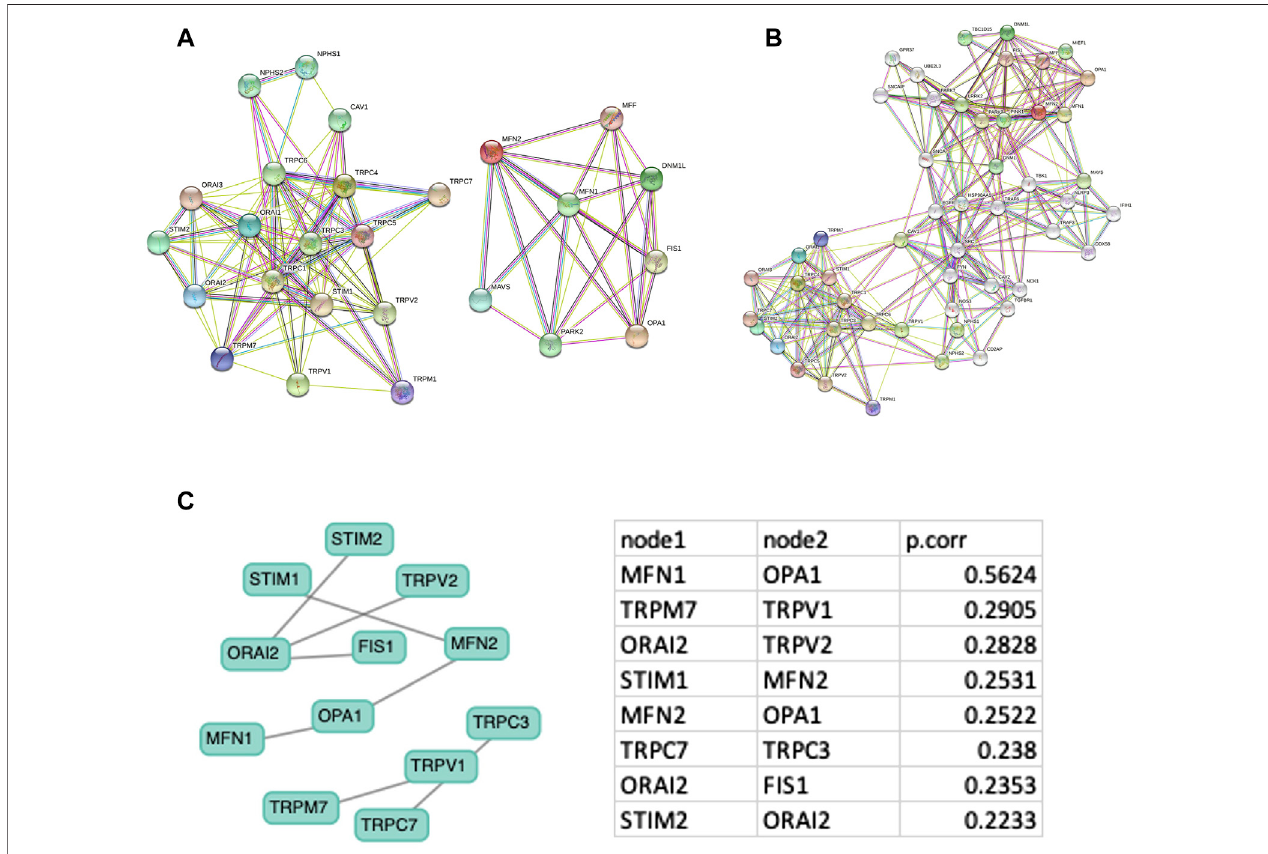
FIGURE 5 | Protein-protein network analysis. Protein-protein interaction network with minimum node (A) and increased node (B) were downloaded from STRING database (C) Gene interaction network is downloaded from GeNeck tool and Pearson correlation for each node is shown.